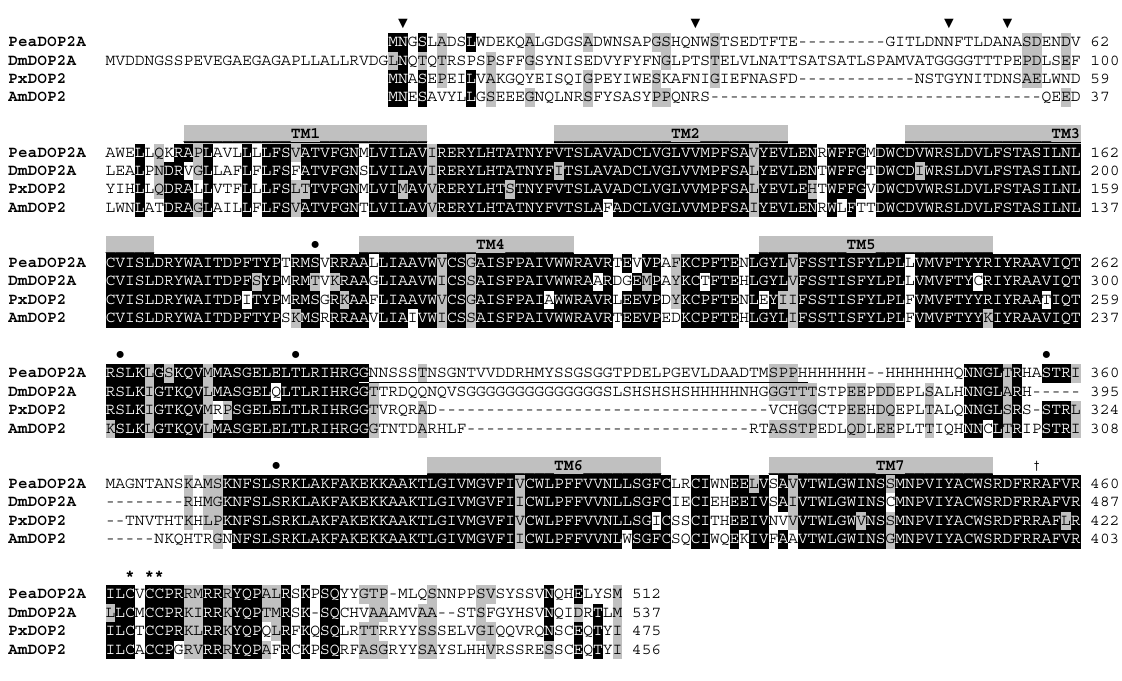
Figure 1. Amino acid sequence alignment of PeaDOP2A and orthologous receptors from Drosophila melanogaster (DmDOP2A, NP_733299), Papilio xuthus (PxDOP2, BAD72870), and Apis mellifera (AmDOP2, AAM19330). Identical residues ( ≥ 75%) are shown as white letters against black, whereas conservatively substituted residues are shaded. Putative transmembrane domains (TM1–TM7) are indicated by gray bars. Potential N-glycosylation sites ( ▼ ), PKC phosphorylation sites ( ● ), and putative palmitoylation sites ( * ) of PeaDOP2A are indicated. Underlined letters represent the region within the 3rd cytoplasmic loop from which the PeaDOP2-specific antigen was derived. R amino acid residue present in the truncated variant PeaDOP2B. The amino acid position is given on the